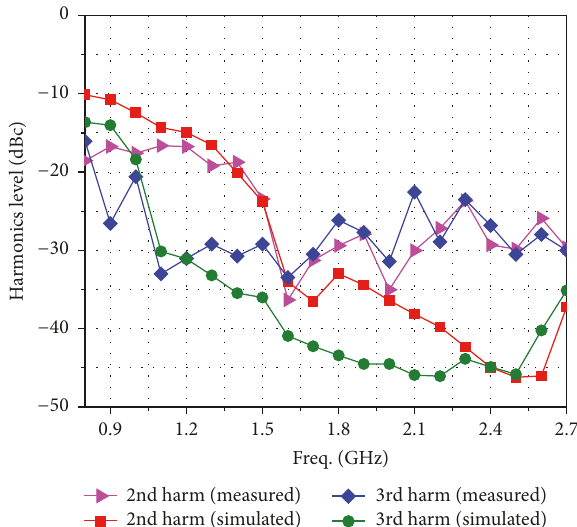
Figure 14: Measured and simulated second and third relative har- monics level. The results are presented relative to the fundamental frequency output